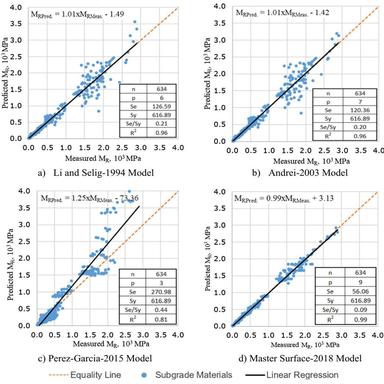
Predicted Values Vs. Measured MR for Subgrade Materials a) Li And Selig-1994 Model, b) Andrei-2003 Model, c) Perez-Garcia-2015 Model, And d) Proposed Master Surface-2018 Model.